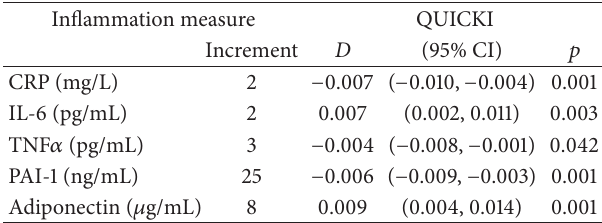
Table 4: Association of the inflammation measures with insulin sensitivity